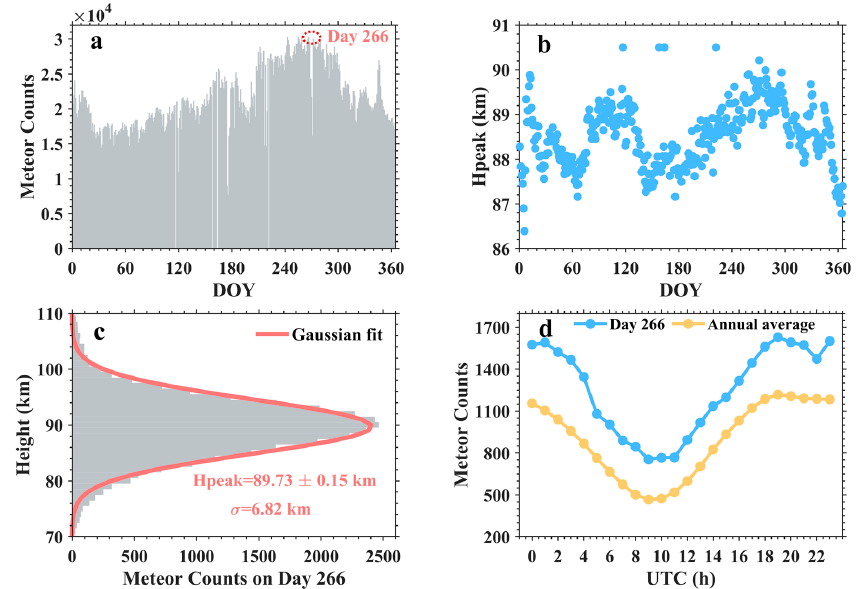
Figure 1. ( a ) Daily total meteor trails detected by Mohe radar in 2013, in which the red circle identifies day 266 in 2013 and the corresponding meteor counts. ( b ) Distribution of daily meteor peak heights. ( c ) Distribution of meteor counts with height in a bin of 1 km on day 266 in 2013, in which the red curve presents a Gaussian fit. Light blue and yellow dotted lines in ( d ) display the hourly meteor count on day 266 in 2013 and the averaged value during the whole study period,